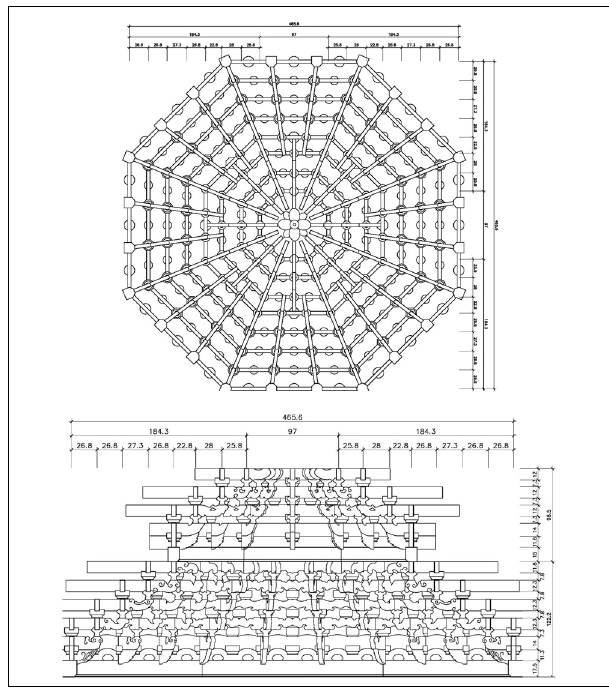
Fig 4. Plan and sectional drawings of the caisson ceiling Wooden elements of caisson ceiling Type